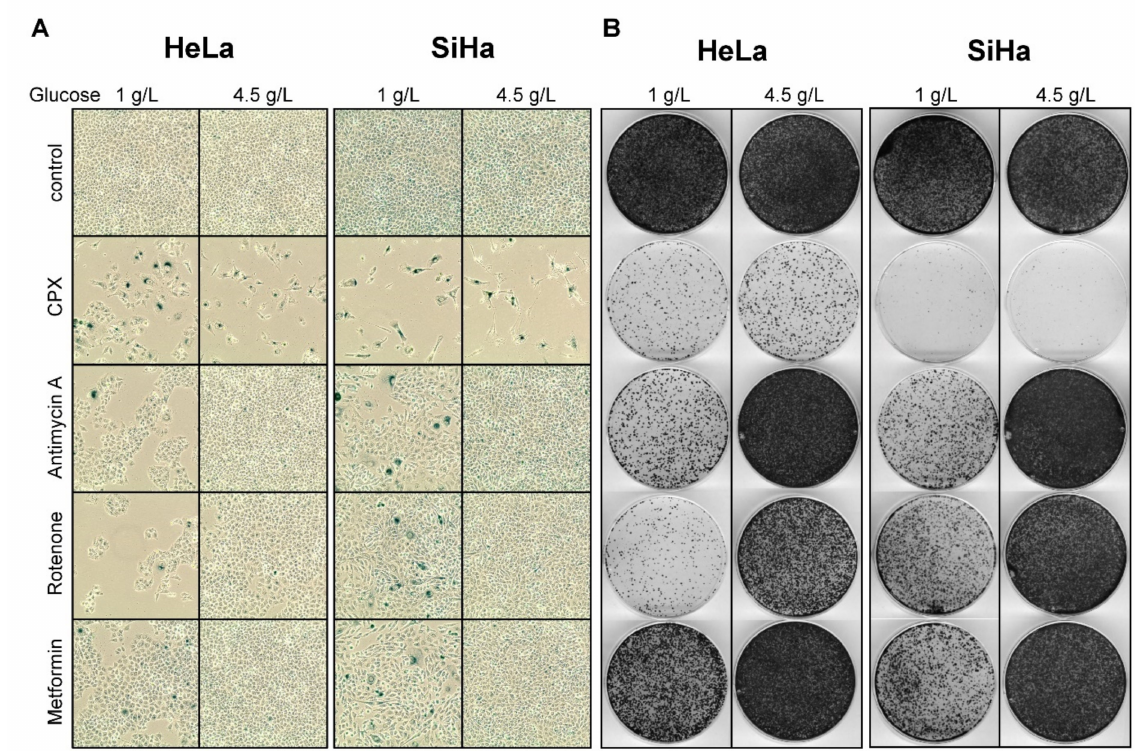
Figure 5. The capacity of CPX to induce senescence under increased glucose availability is not shared by other OXPHOS inhibitors. ( A ) Senescence assays of HeLa or SiHa cells treated with the indicated OXPHOS inhibitors for 72 h under 1 g/L or 4.5 g/L glucose. Before SA- β -gal assays were performed, cells were released in drug-free medium (1 g/L glucose) for 4 days. The following drug concentrations were used: 10 µ M CPX; 2 nM (HeLa)/ 5 nM (SiHa) antimycin A; 20 nM rotenone; 2.5 mM (HeLa)/ 7.5 mM (SiHa) metformin. Scale bar: 200 µ m. ( B ) Concomitant CFAs to ( A ), cells were released in drug-free medium (1 g/L glucose) for 11 days before fixing and staining